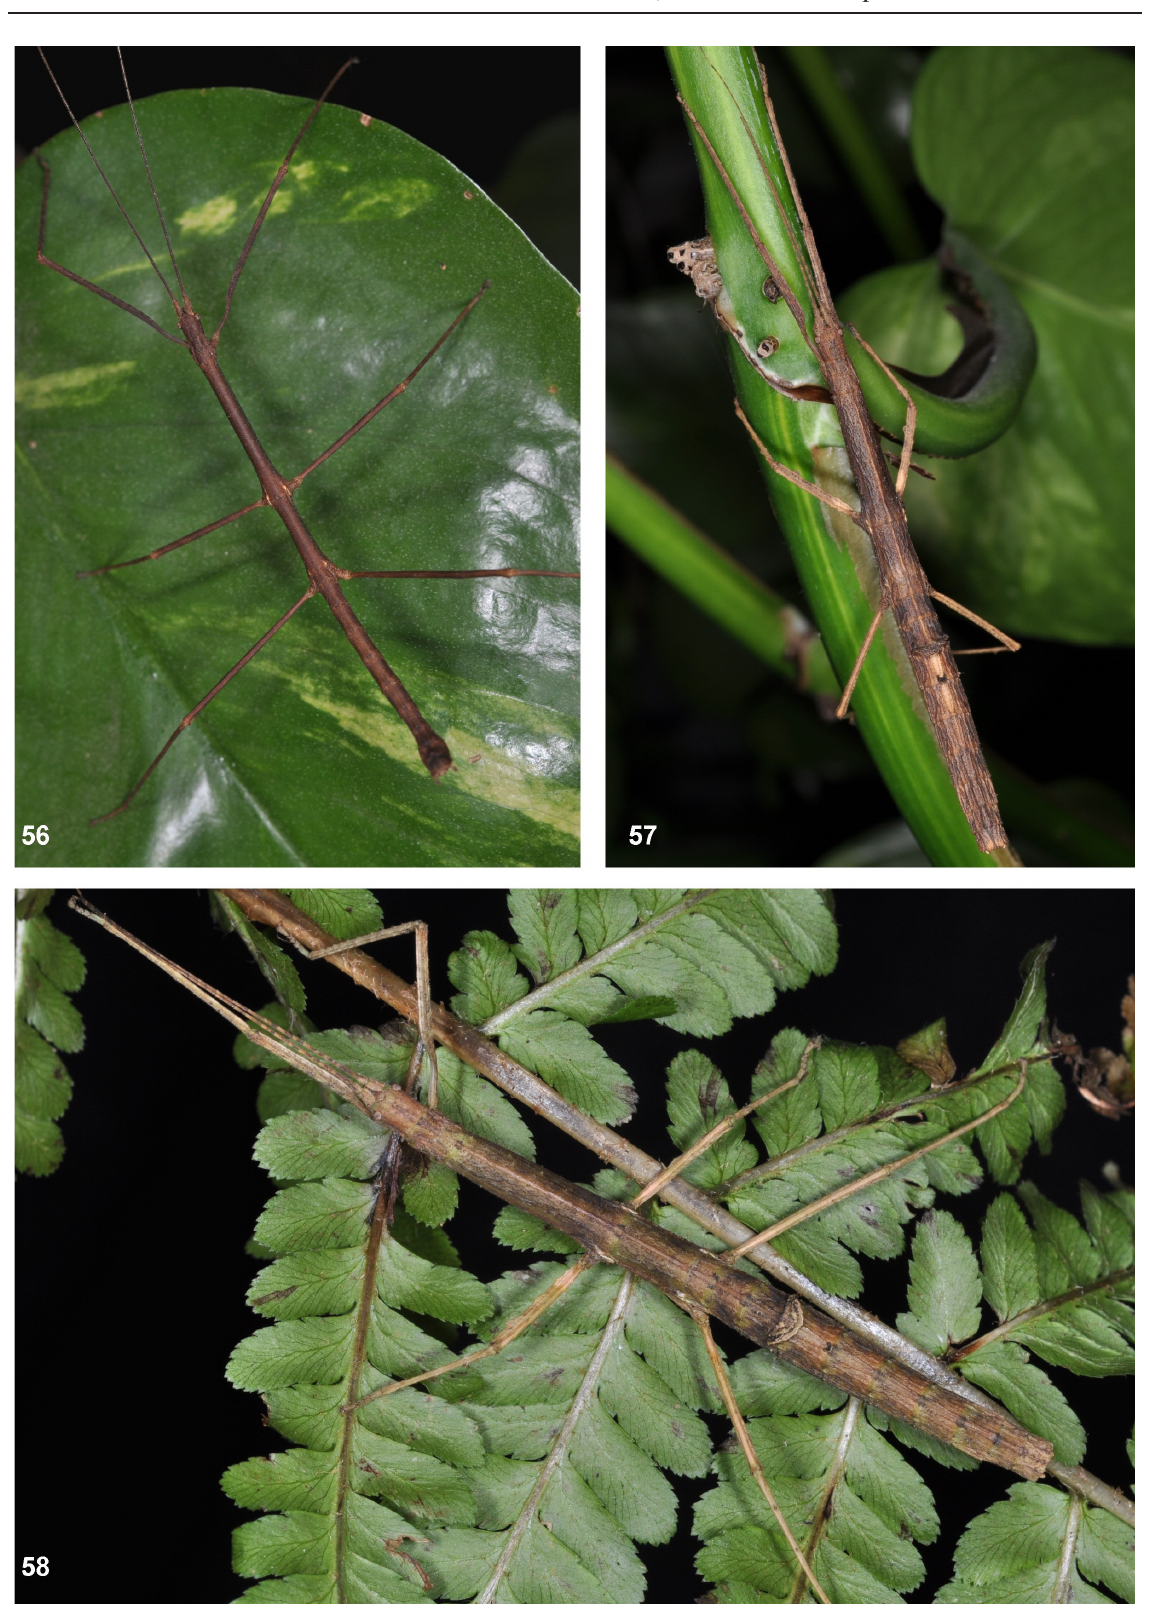
Figs 56–58. Lobolibethra carbonelli sp. nov. 56. Live ♂, PT (FH). 57. Live ♀, PT (FH). 58. Live ♀, PT